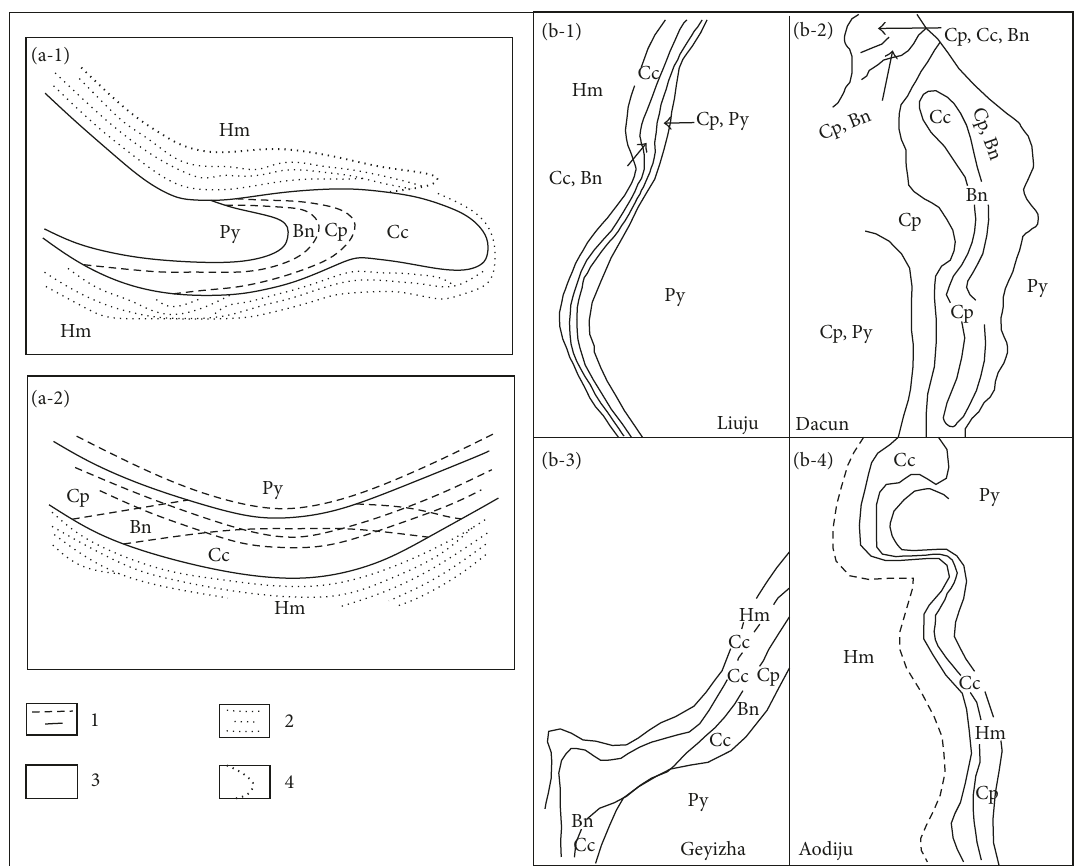
Figure3:(a)Two-ideazoningpatternofmetalmineralsinred-bedcopperdepositsintheChuxiongbasin;(b)patternofmetalmineralzoning in the section (modified by [23]). (a-1) Horizontal zoning; (a-2) vertical zoning; 1: light grey sandstone; 2: purple sandstone; 3: orebodies;